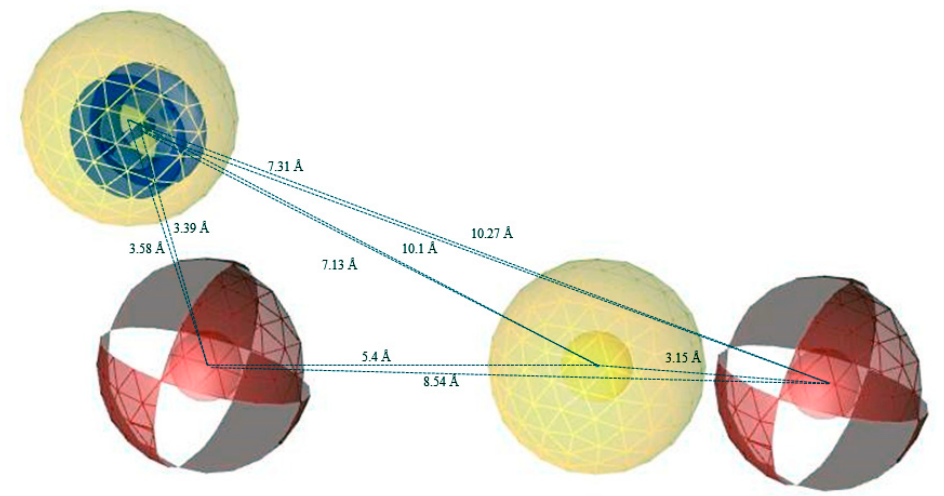
Table 1. The hit rate of all four libraries in the pharmacophore model validation.